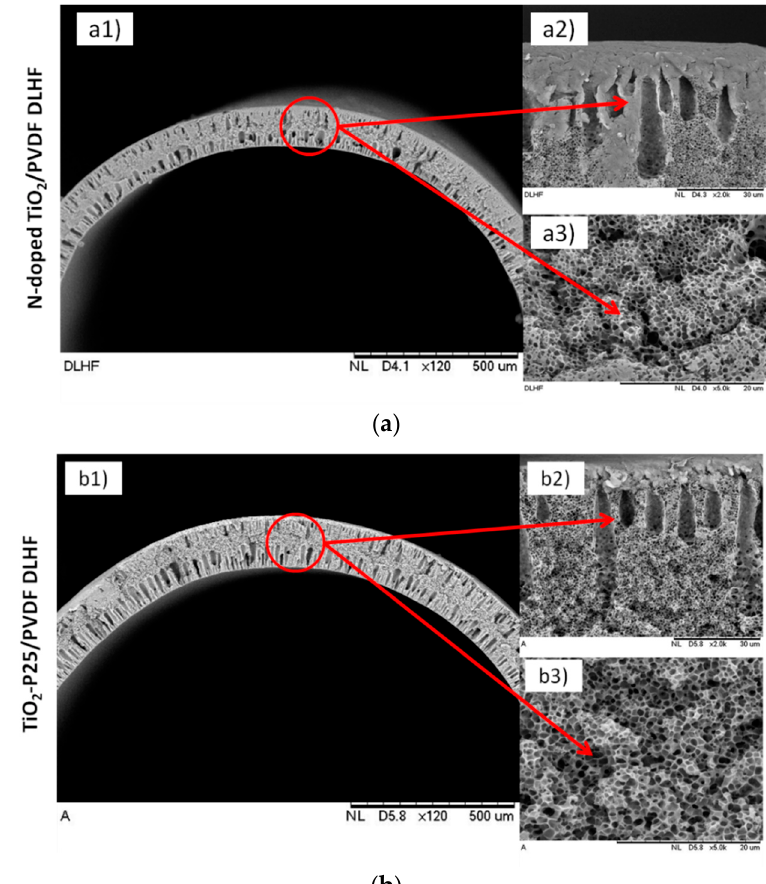
Figure 1. SEM cross-section morphological analysis of DLHF membranes; ( a ) N-doped TiO 2 DLHF and ( b ) TiO 2 -P25 DLHF (a1 and b1 represent the cross-sectional morphology, a2 and b2 represent the finger like morphology and a3 and b3 represent the sponge-like